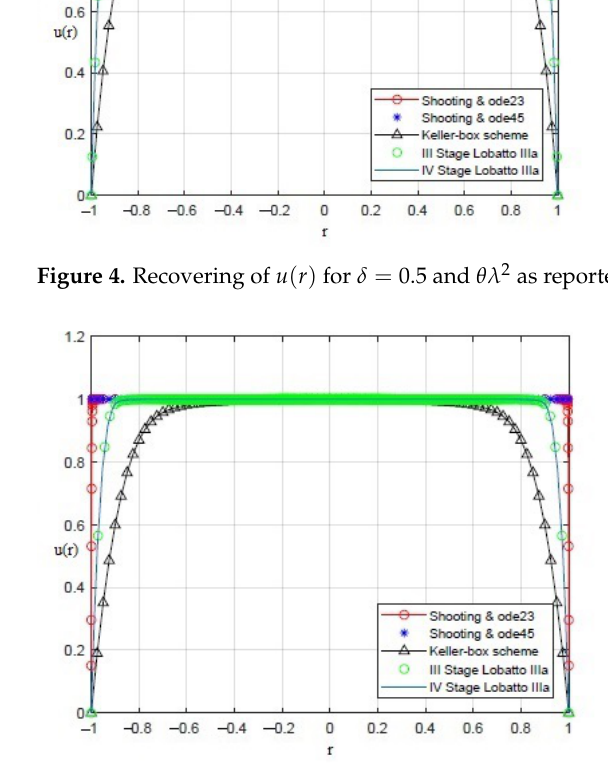
Figure 5. Recovering of u ( r ) for δ = 1 and θλ 2 as reported in Tables 1 and